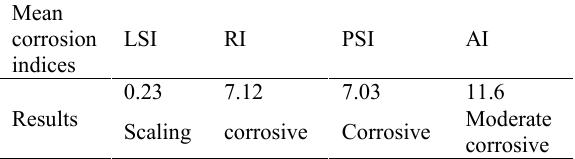
Table 4. Results of the corrosive potential of rural water supplies of